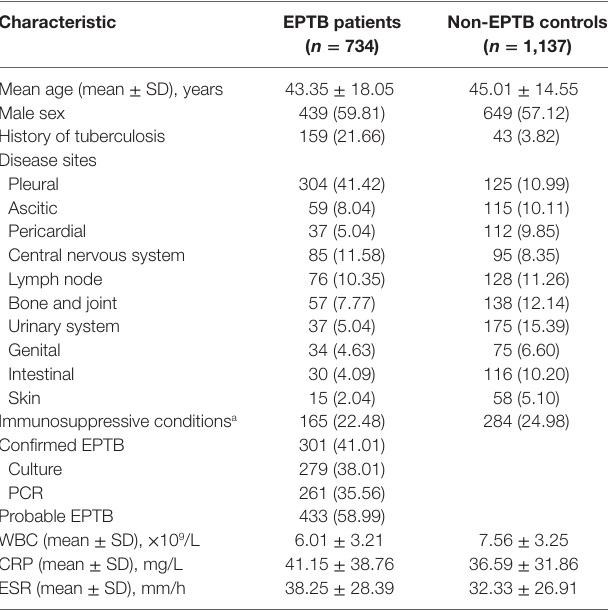
TaBle 1 | Demographic and clinical characteristics of EPTB patients and non- EPTB controls.